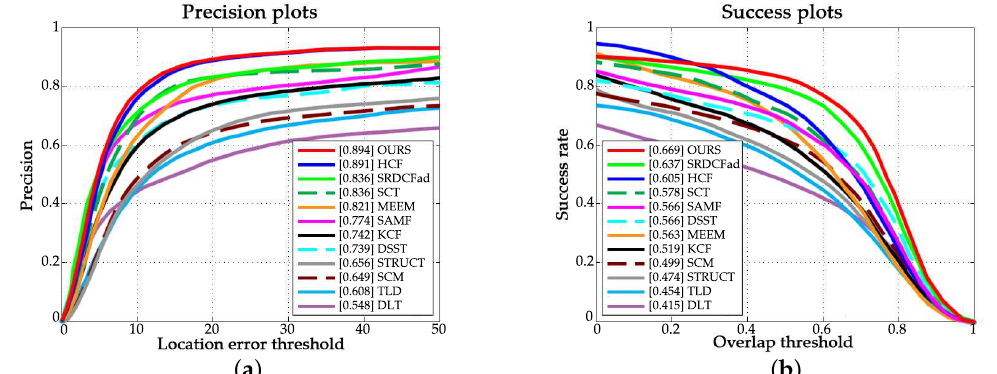
Figure 3. Precision and success plots over the OTB-2013 dataset. ( a ) Precision plot; ( b ) Success plots.